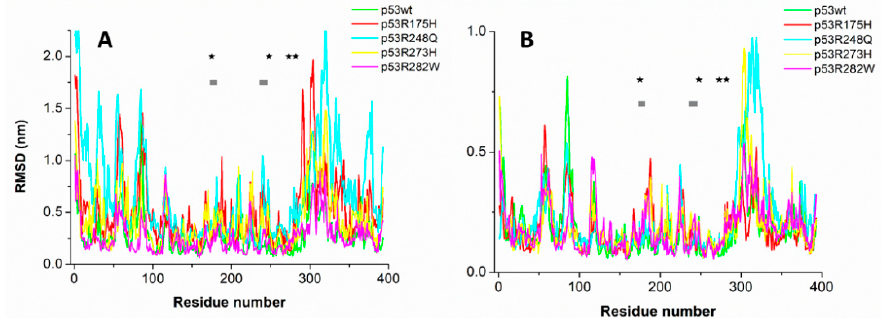
Figure 2. ( A ) RMSD and ( B ) RMSF as a function of the residue number. Positions of the residues submitted to mutations are marked by black stars, while those of residues involved in the DNA binding are marked by grey squares.